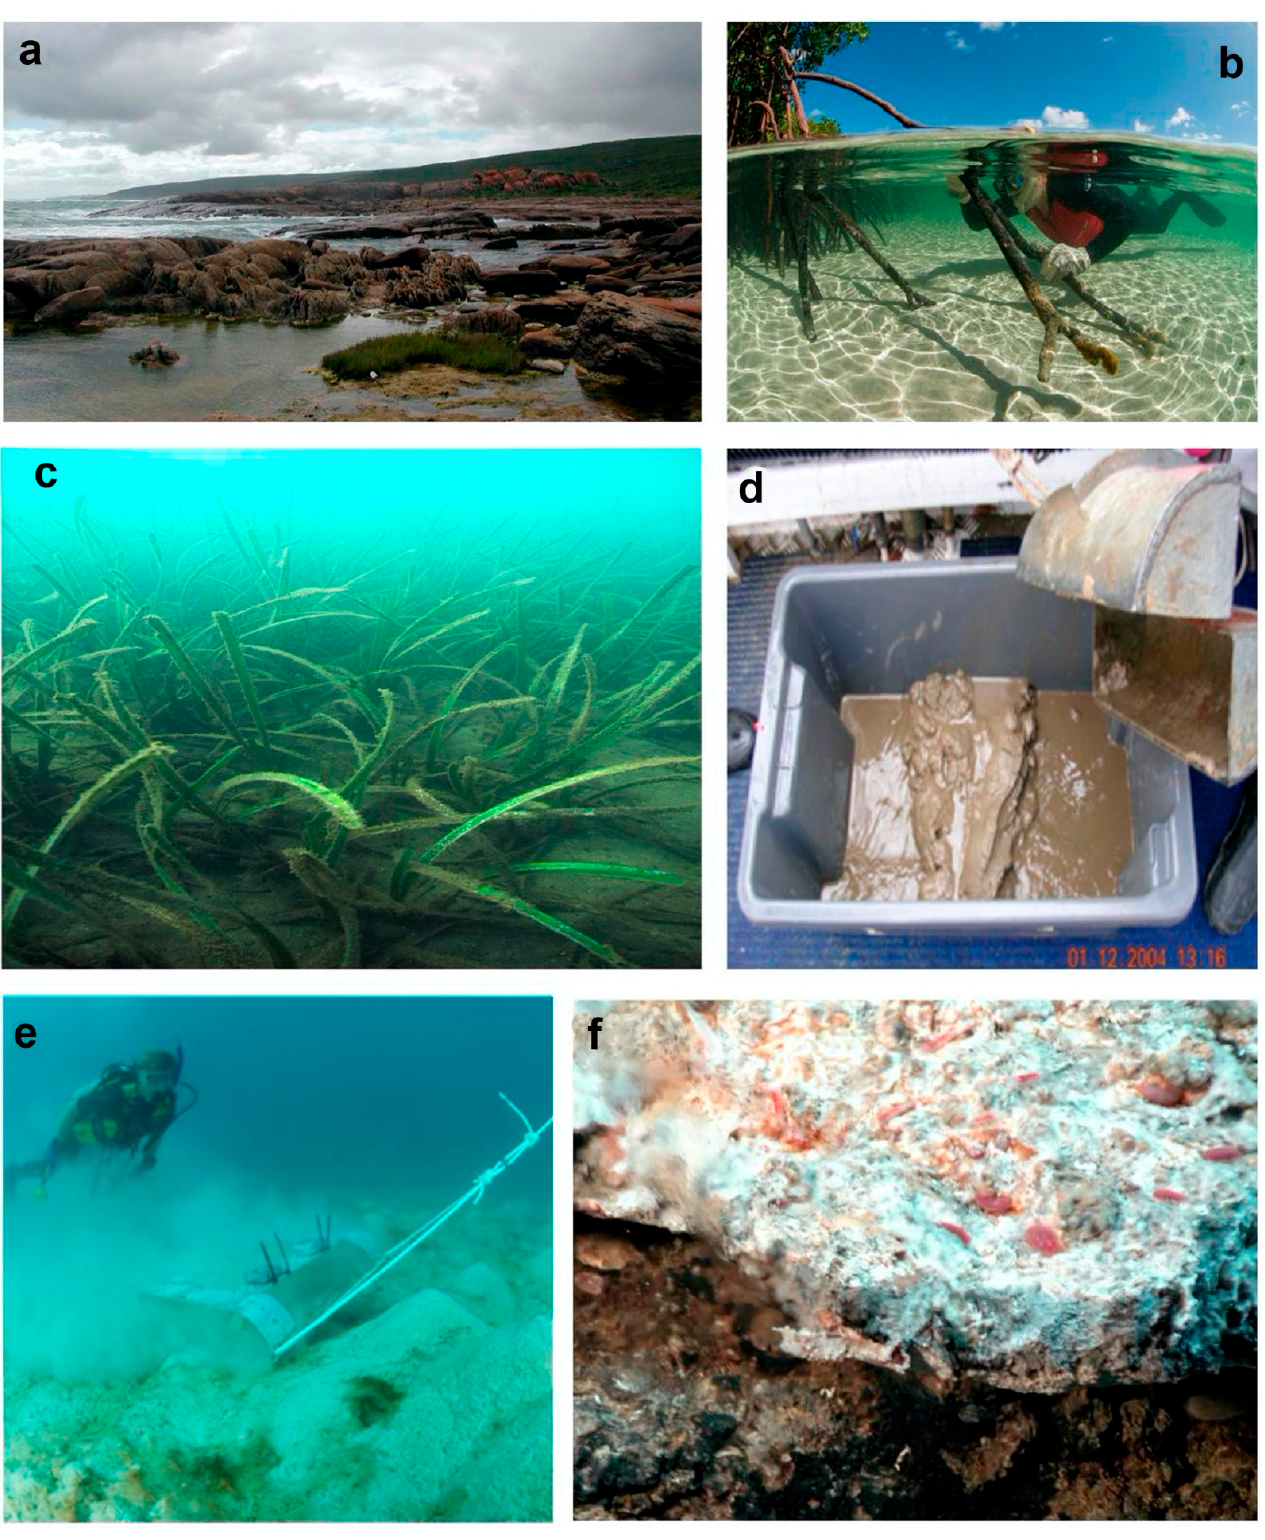
Figure 7. Some typical habitats of terebelliforms: ( a ) wave-dominated coastline, Cape Leewin, WA, Australia. Photo: Pat Hutchings; ( b ) mangrove area in front of Rhizophora roots at Lizard Island. Photo: Gary Cranitch; ( c ) base of Posidonia australis beds. Photo: Clay Bryce; ( d ) soft mud, here collected by Van Veen grab. Photo: Pat Hutchings; ( e ) fine sand sampled by dredge. Photo: Jeurgen Freund; ( f ) deep-sea hydrothermal vents, tubes of alvinellids. Chimney wall surface at Tu’i Malila, Lau Basin. Copyright: Chubacarc cruise/Ifremer.